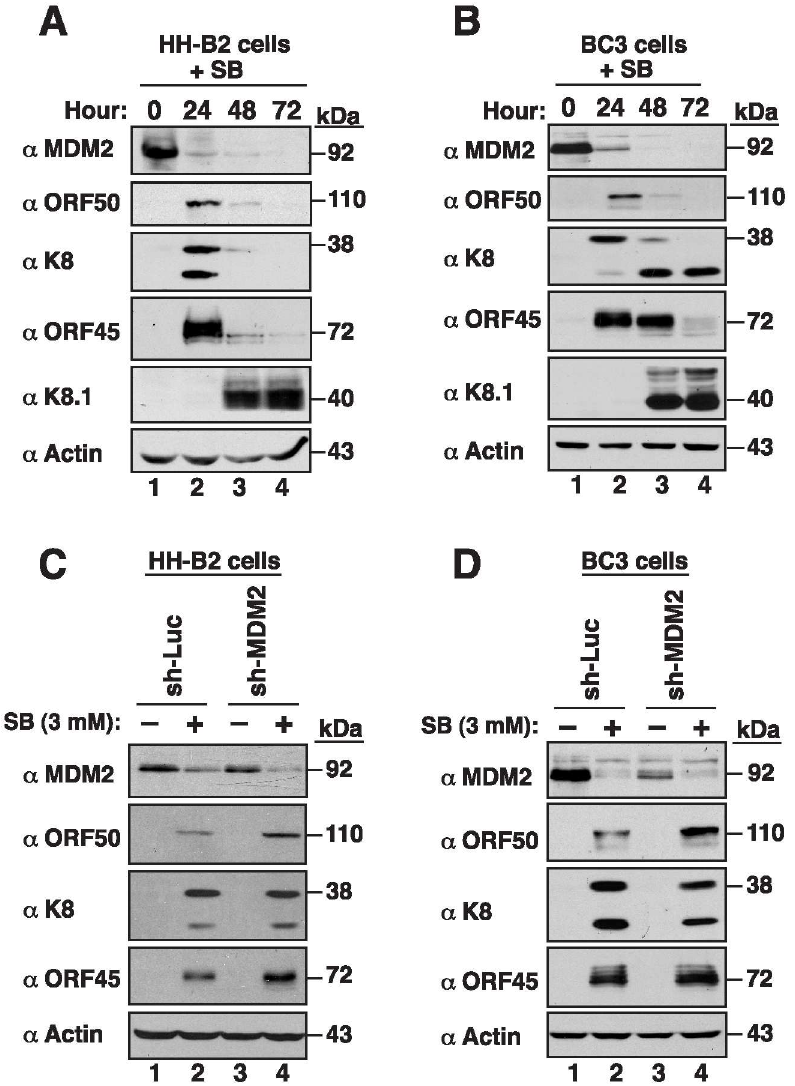
Fig 12. MDM2 negatively regulates ORF50 expression in KSHV-infected cells. The expression kinetics of MDM2 and viral lytic proteins (includingORF50, K8, ORF45, K8.1) were analyzedin HH-B2 (A) and BC3 cells (B) after treatment with sodium butyrate (SB). (C and D) The lentiviral vector-mediated MDM2 knockdown was performed in HH-B2 and BC3 cells. At 24 hr after lentiviral infection, HH-B2 or BC3 cells were either untreated or treated with SB for another 18 hr. The expression of MDM2, ORF50, K8 and ORF45 was determinedby immunoblotting with the